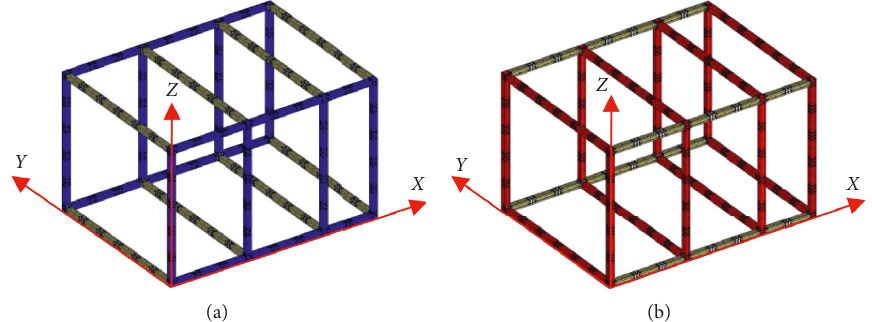
Figure 17: Wall frames and their corresponding orthogonal beam frames. (a) Wall frames in two planes parallel to XZ : 2(F18M), 2(F18M) y 2(F12M) (blue colour), (b) beam frames in two planes parallel to YZ : 4(F36M) (red colour).